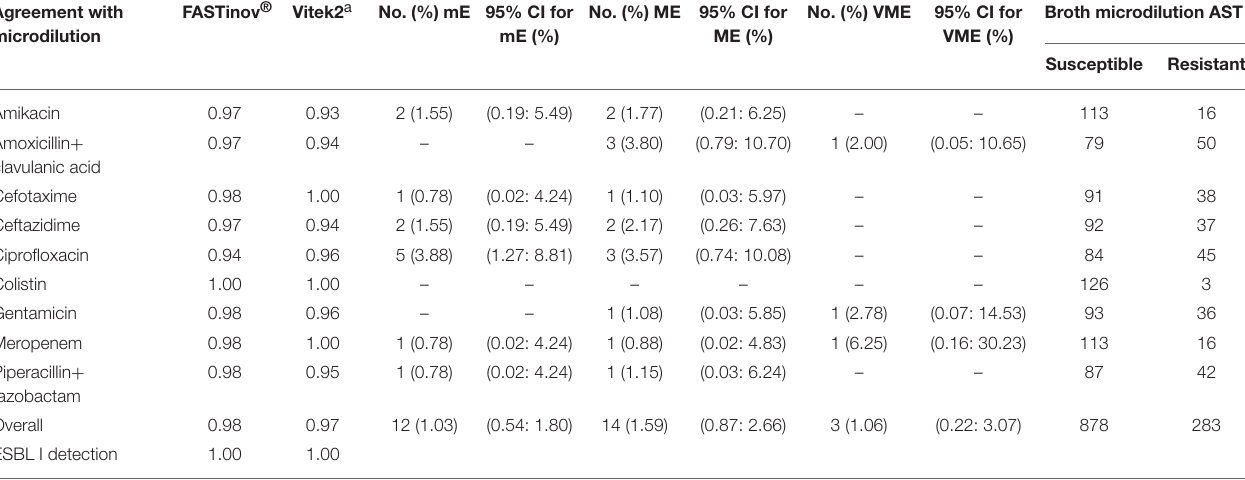
TABLE 3 | Categorical agreement between FASTinov ® Gram negative test or Vitek2 (bioMérieux) and broth microdilution; FASTinov ® gramneg kit error rate. Agreement with